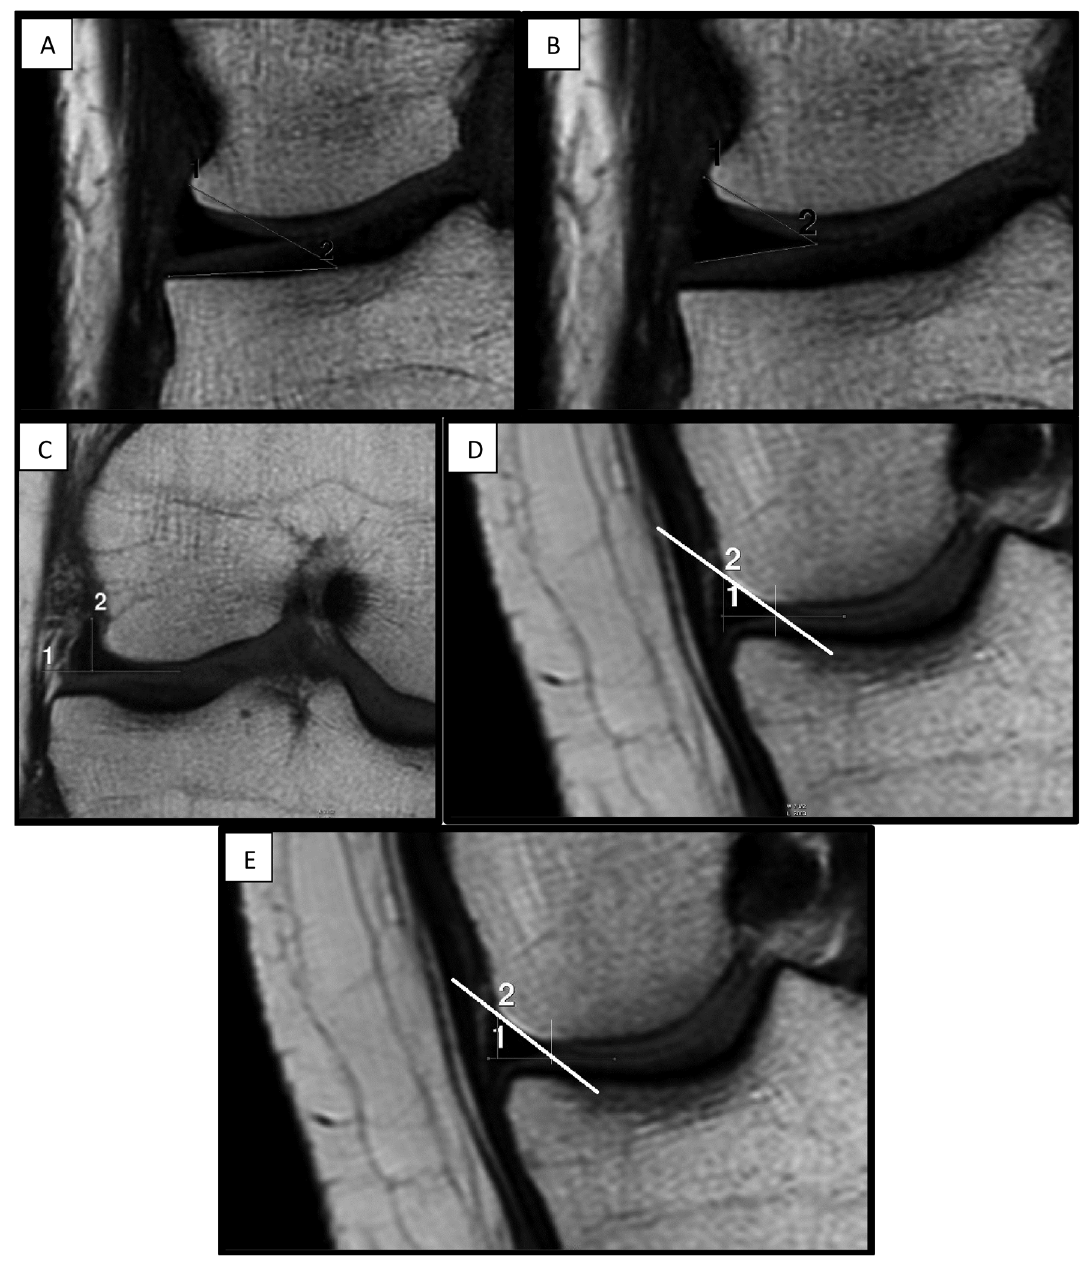
Fig 2. A-E. The central slice of a coronal MRI imaging of the knee focused on lateral compartment: A) meniscus-bone angle, B) meniscus-cartilage angle, C) meniscus-cartilage height, D) slope A, E) slope